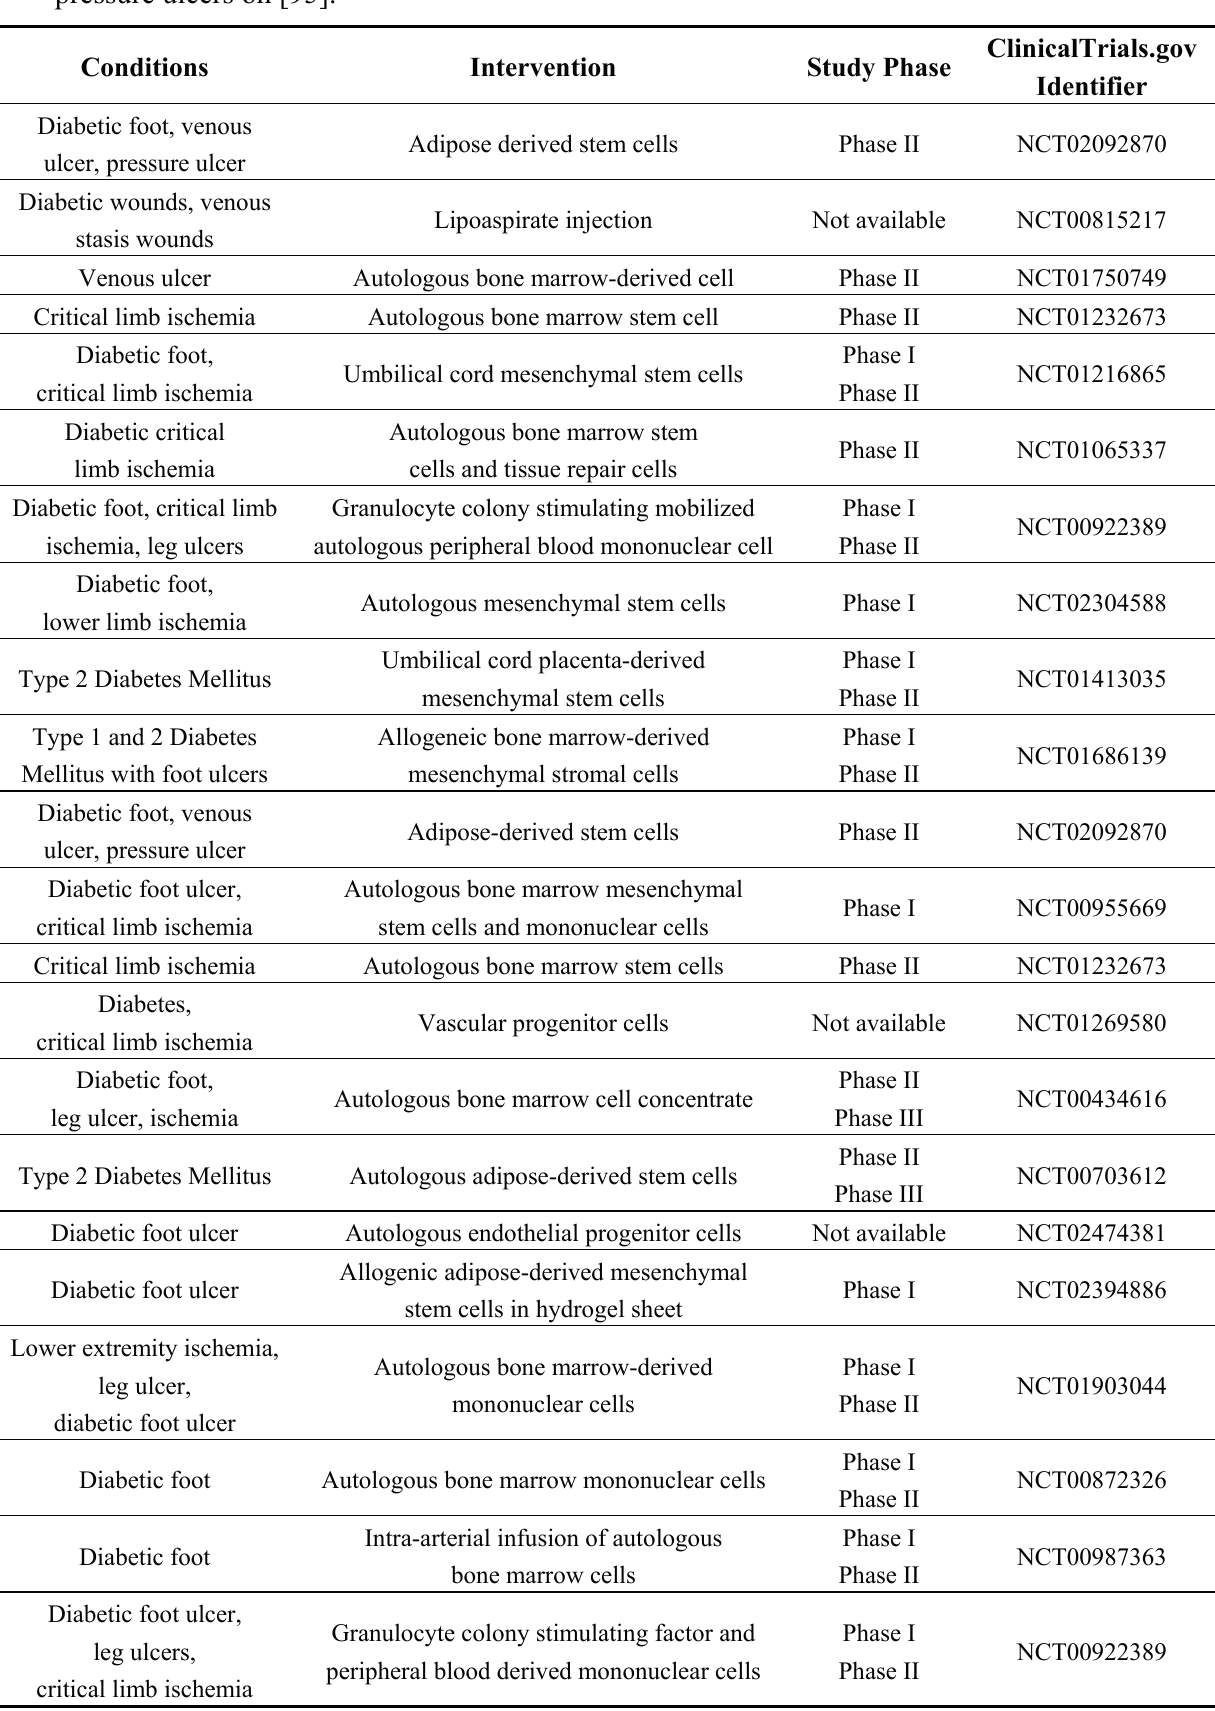
Table 3. Clinical trials of stem-cell based therapy for venous ulcers, diabetic foot ulcers, and pressure ulcers on